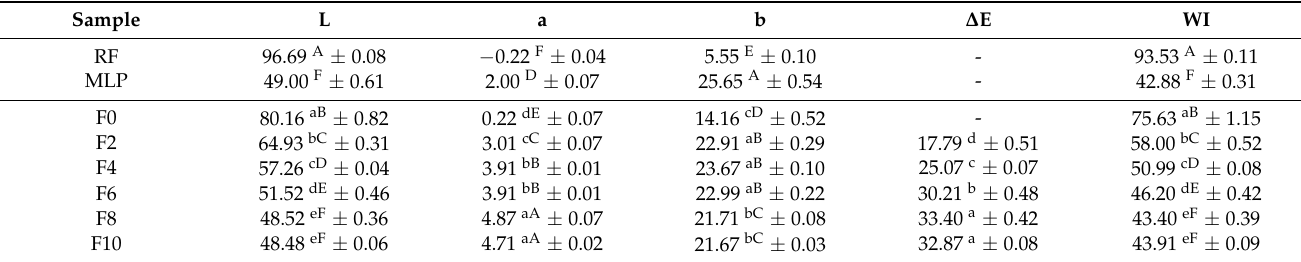
Table 2. Color characteristics of the RF, MLP, and FRN.